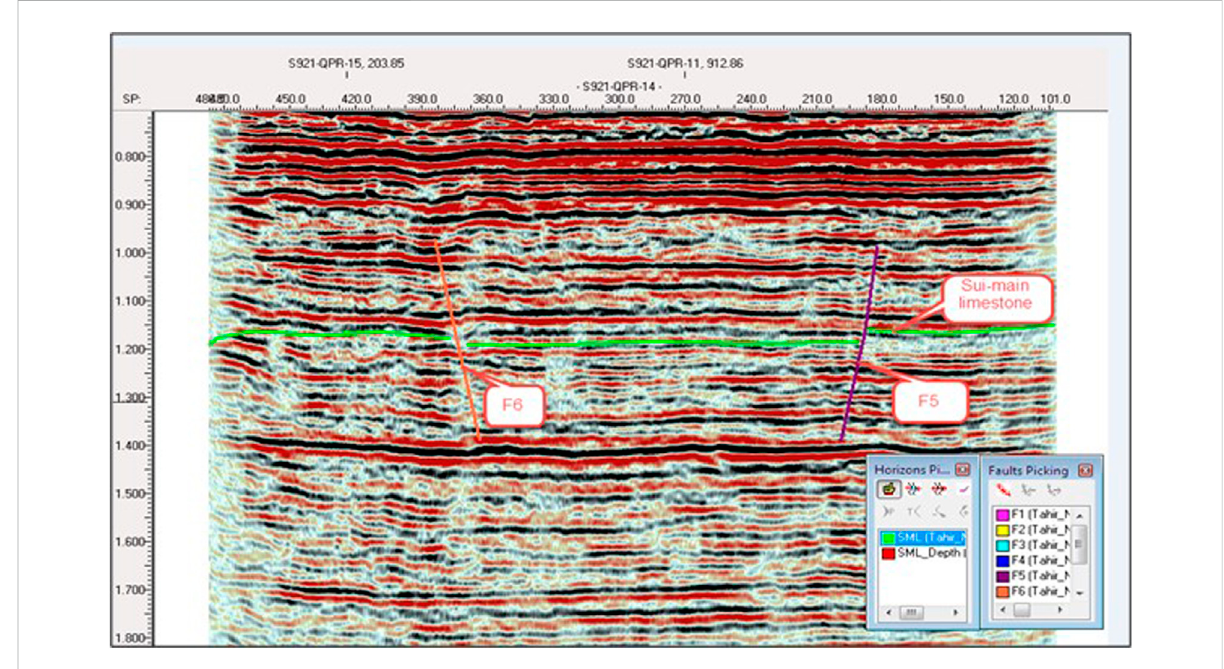
FIGURE 2 Interpreted 2D seismic time section. Sui Main Limestone is marked a re fl ector along with major